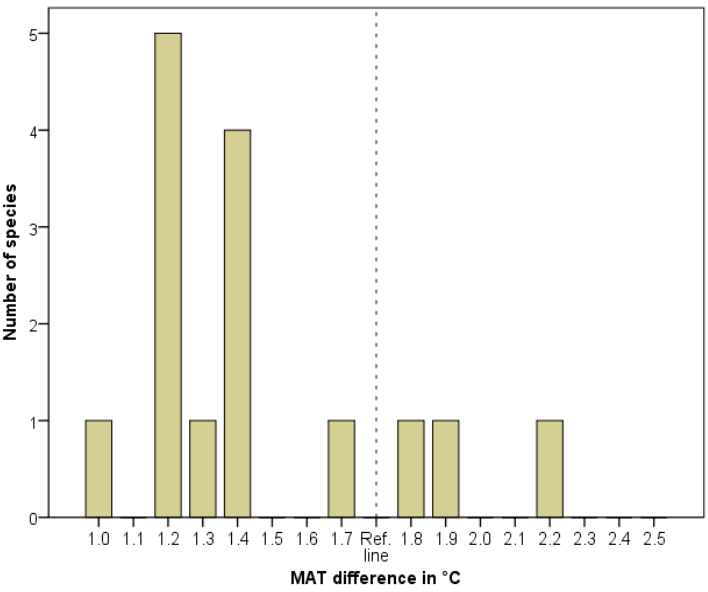
Figure 4. Distribution of indicated MATD. Frequency = number of species in a certain 0.1 °C interval.